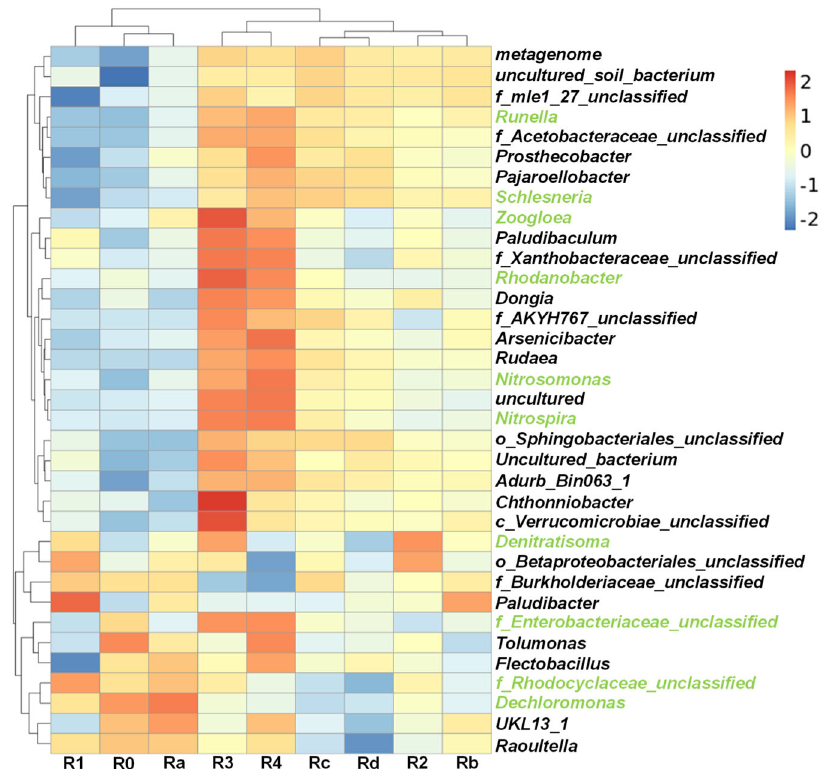
Fig. 7 Heatmap at the genus level. The names of key genera for nitrogen removal are marked in green, and the red and blue colors in the heatmap represent the low and high percentages of OTUs, respectively (R0: suspended fl ocs; Ra – Rd: attached bio fi lms on each bioplate; R1 – R4: biomass entrapped in the bioplates, as shown in Fig.